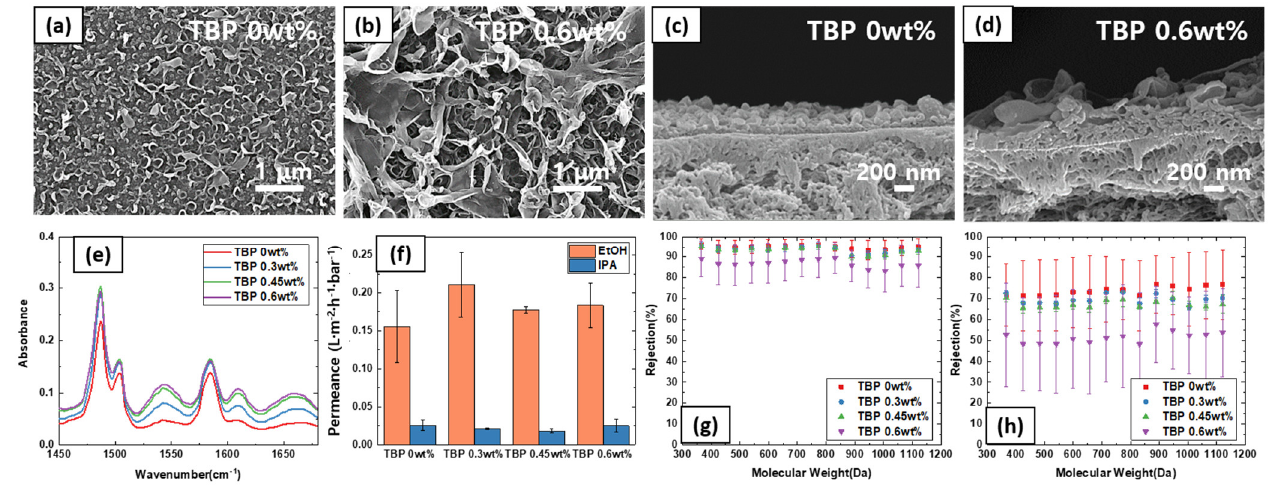
Figure 3. Effect of TBP additives in the organic phase on ( a , b ) surface SEM images, ( c , d ) cross-sectional SEM images, ( e ) FTIR spectra ( f ) solvent permeance, ( g ) PPG rejection profile in EtOH, and ( h ) PPG rejection profile in IPA.